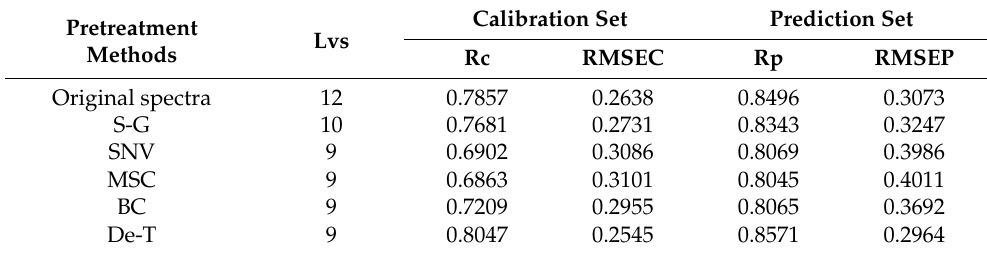
Table 2. Results of PLS models based on different spectral pretreatment methods.